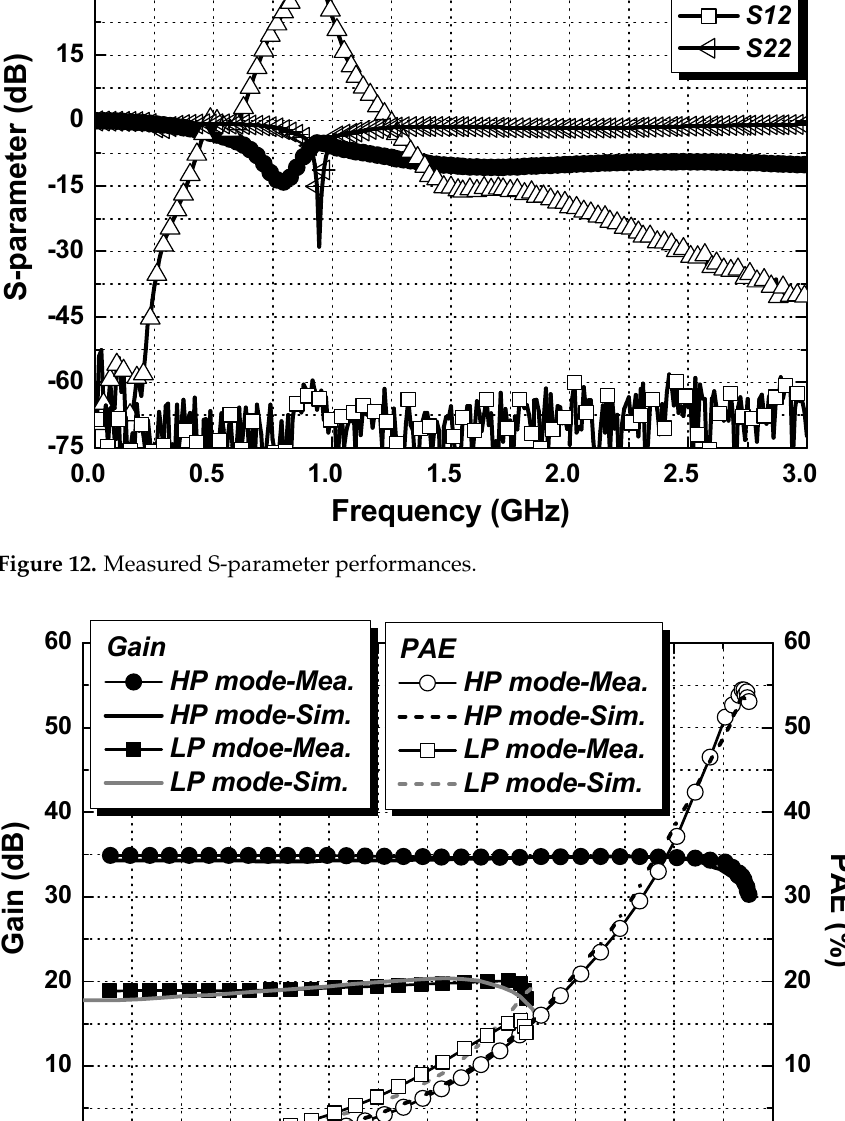
Figure 14. Measured IMD3 results.